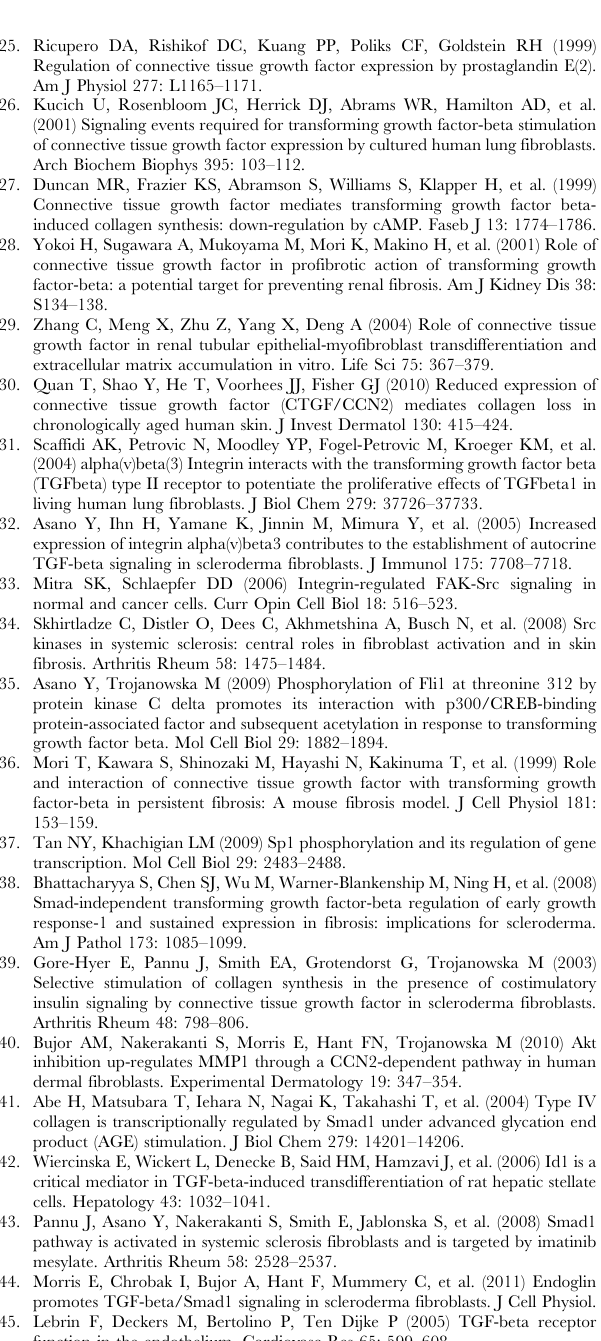
(TIF) Figure S3 TGF- b induced Smad1 phosphorylation is mediated through Src (A) Foreskin fibroblasts were transfected with Src siRNA oligos and mRNA levels of Src was measured (n= 3, * p , 0.01). (B) Foreskin fibroblasts were pretreated with Src inhibitor SU6656 for 1 hour and then stimulated with TGF- b for 30 minutes and analyzed for Smad1 phosphorylation. (TIF)